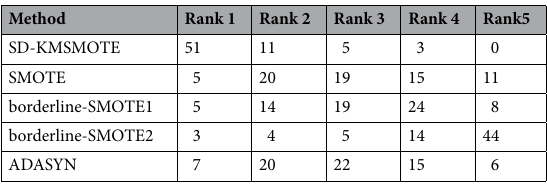
Table5. Heat map table of experimental